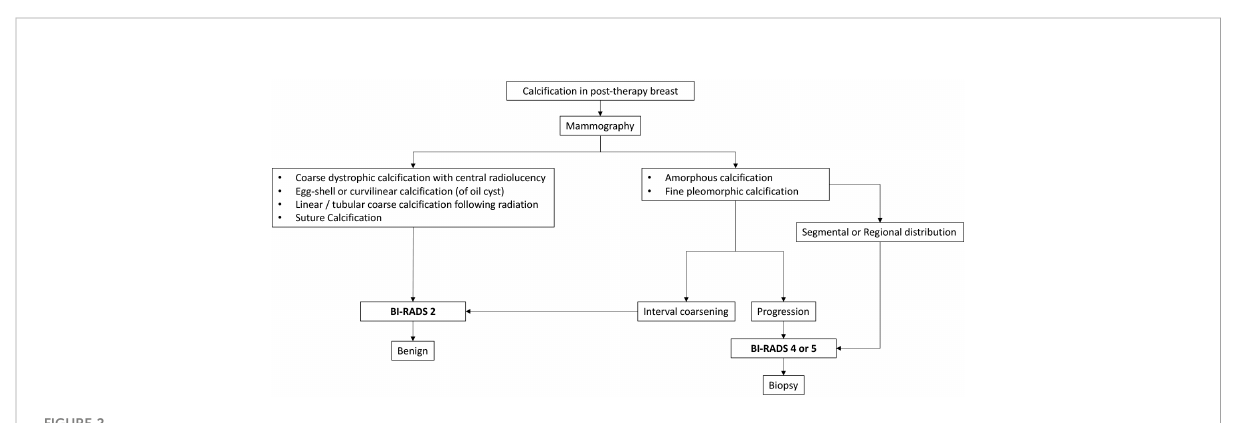
FIGURE 2 Algorithm for the approach to calci fi cations seen in fat